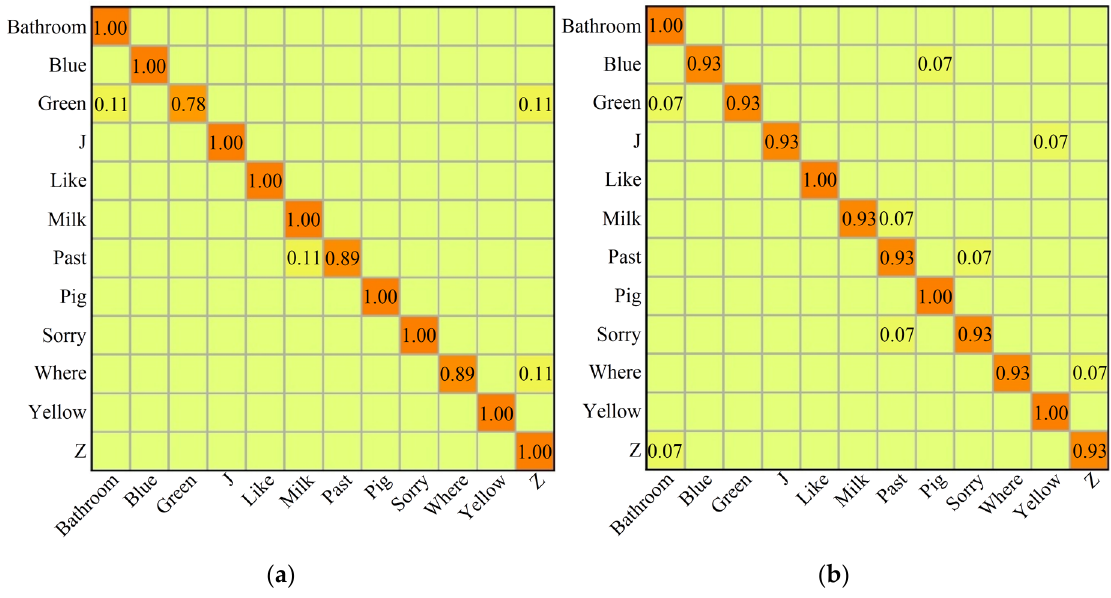
Figure 10. Heat-maps of the confusion matrix for the recognition of the ASL dataset. ( a ) The heat-map of the ASL dataset with 360 samples; ( b ) The heat-map of the ASL dataset with 480 samples.